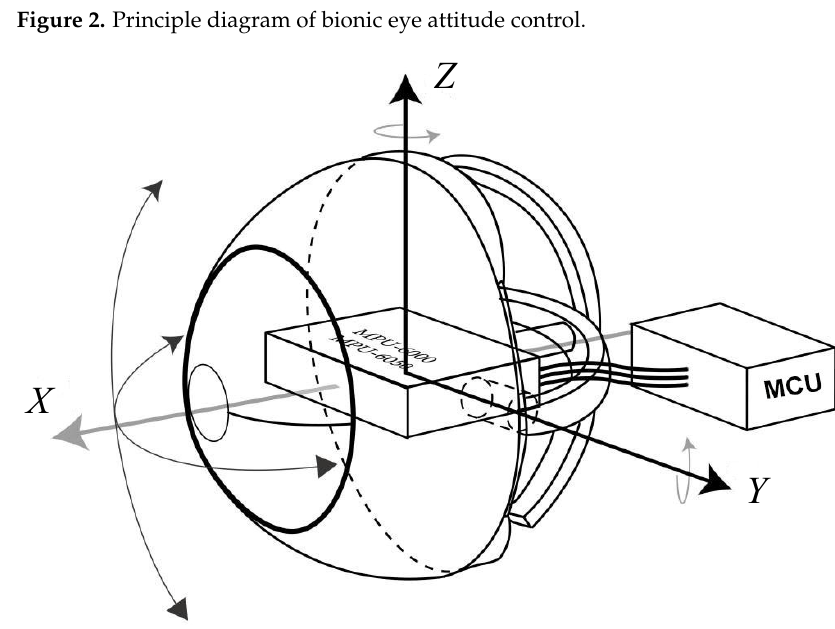
Figure 3. Principle diagram of connection of IMU and MCU.